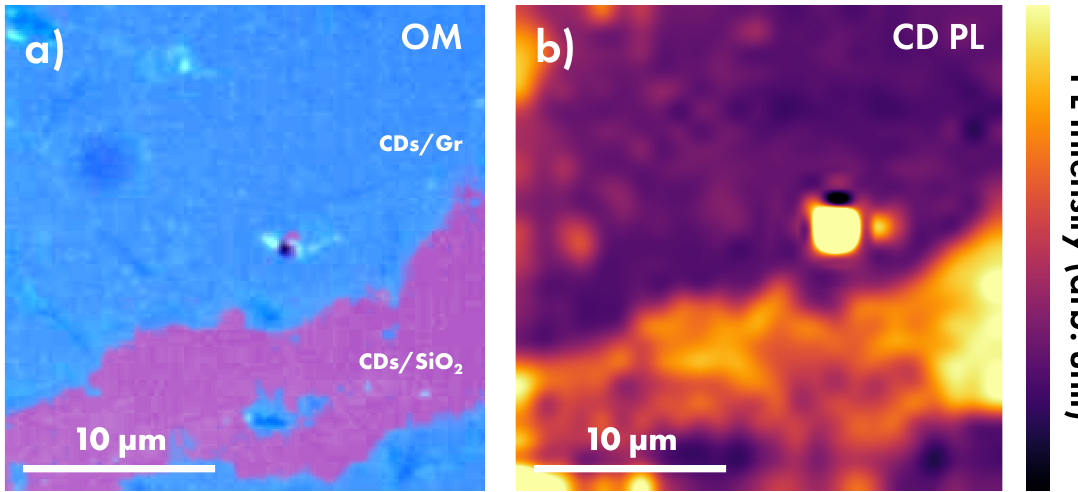
Figure 5. ( a ) Optical microscopy image and corresponding ( b ) µ -PL mapping excited at 532 nm of CDs deposited on contiguous regions of undoped graphene (CDs/Gr) and SiO 2 (CDs/SiO 2 ). The intensity of CD emission (CD PL) is reported in the